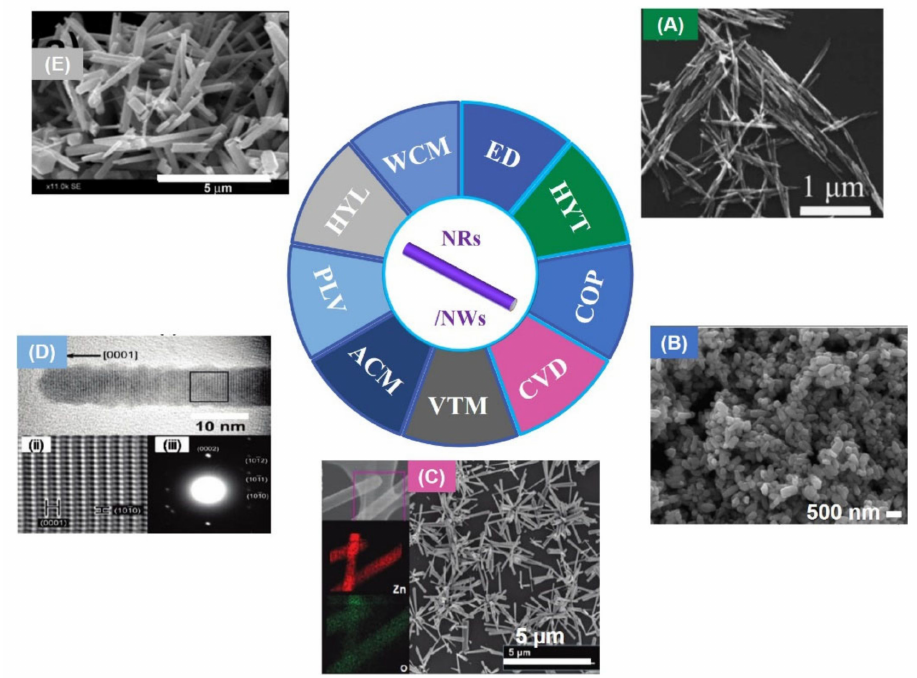
Figure 4. ZnO NRs/NWs. ( A ) ZnO NRs obtained by hydrothermal method (HYT) (Reproduced with permission from [67]. Copyright 2008, American Institute of Physics). ( B ) ZnO NRs prepared by coprecipitation method (COP) (Reproduced with permission from [68]. Copyright 2009, Elsevier). ( C ) SEM images of ZnO NWs (Reproduced with permission from [69]. Copyright 2010, Ameri- can Chemical Society). ( D ) HRTEM image of ZnO NRs (Reproduced with permission from [69]. Copyright 2010, American Chemical Society). ( E ) ZnO NRs synthesised by wet chemical method (WCM) (Reproduced with permission from [72]. Copyright 2018, Elsevier). Electro-deposition (ED); Chemical vapor deposition (CVD); Pulsed laser vaporization (PLV); Aqueous chemical method (ACM); Hydrolysis